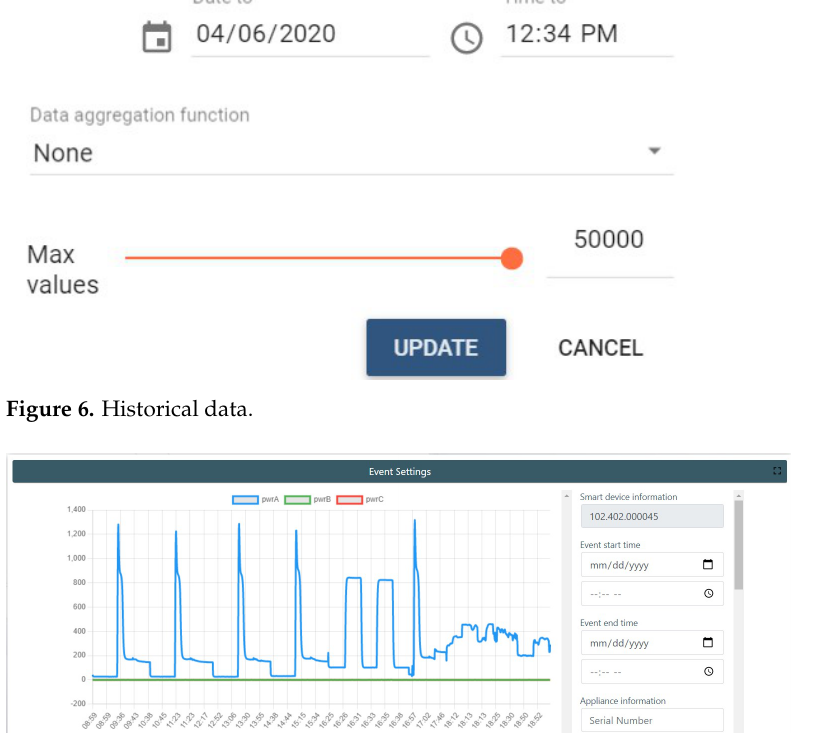
Figure 7. Setting event